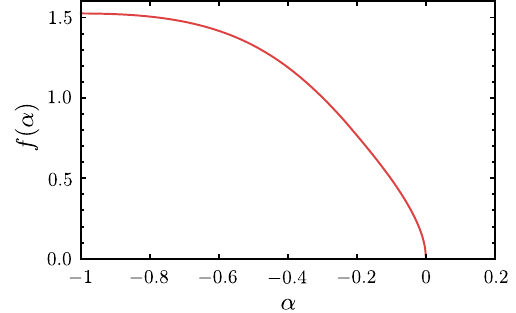
FIG. 8. Imaginary part of the scaling dimension of the fermion number operator Q . At α ¼ − 1 , it reaches its maximum value of approximately